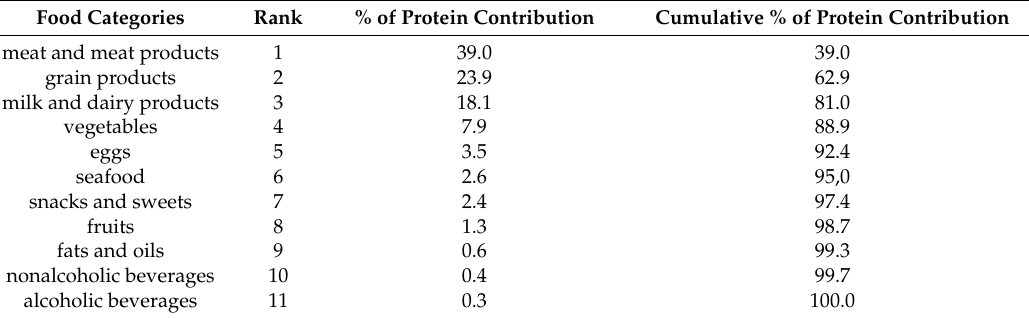
Table 2. Food category sources of protein contribution to the average Polish